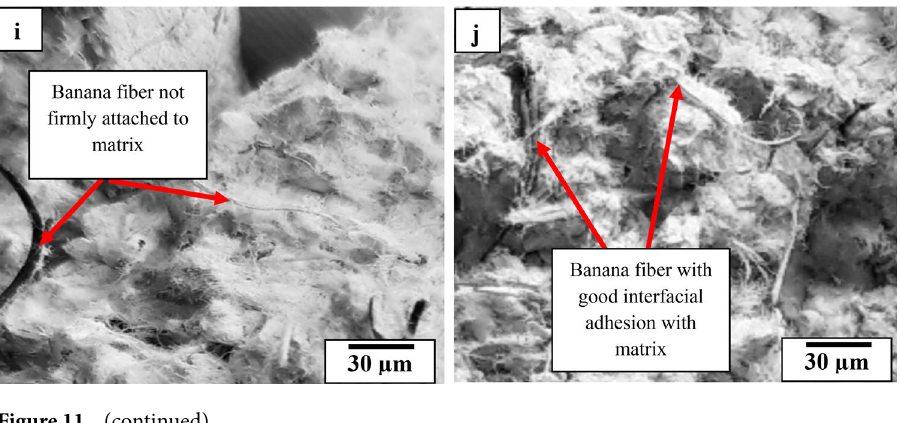
1. water absorption increased slightly with banana fiber loading, howbeit samples infused with modified fibers absorbed lesser water volume than the unmodified ones. Moisture absorption increased with rising UMBF dosage while consecutive addition of AMBF resulted in a decrease in moisture assimilation 2. mechanical strengths were boasted with fiber inclusion even as the modified fibers presented higher enhance- ment. Curing duration also participated effectively in strength enhancement. 3. alkaline modification and curing were noted to be effective in improving the properties and performance of paperbricks, and therefore recommended for property optimization in